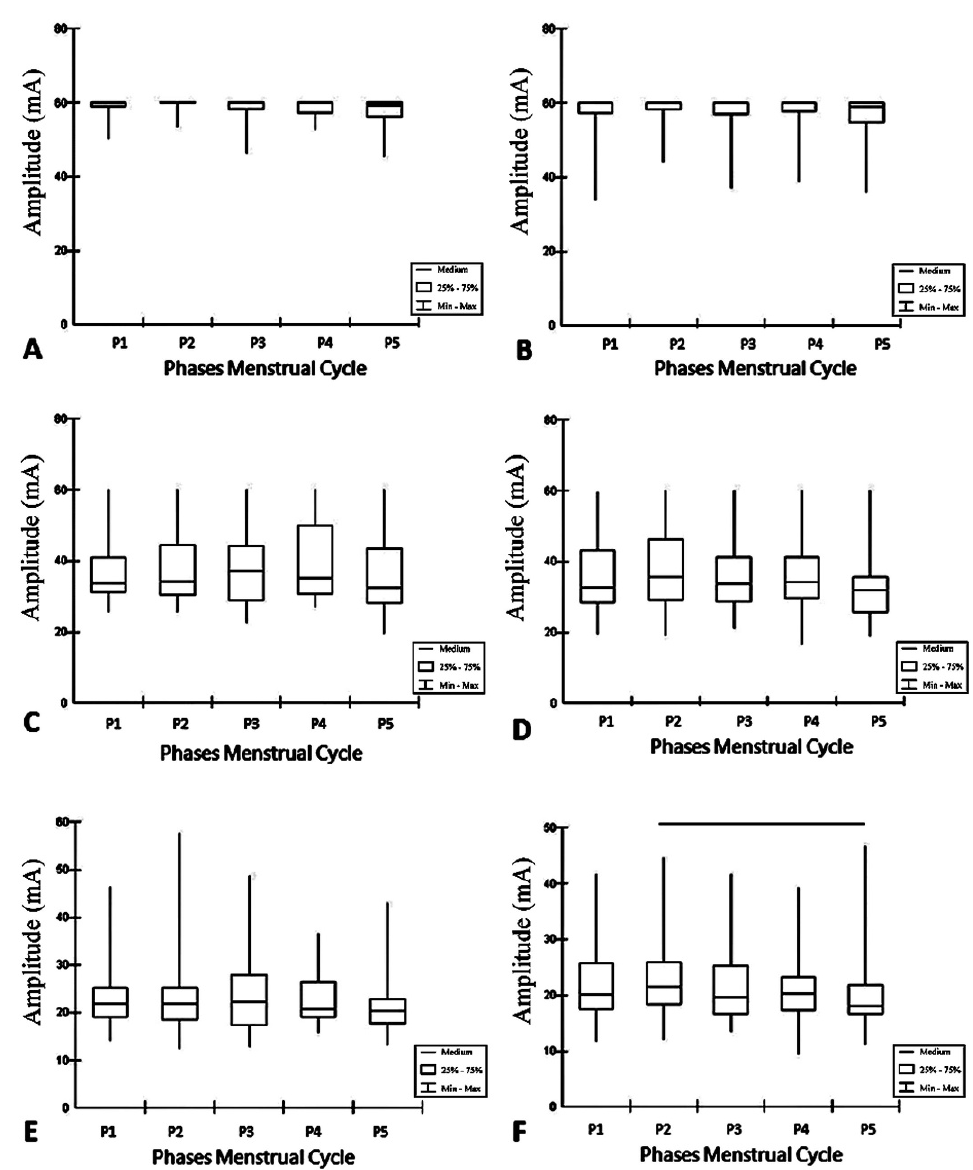
Figure 3 - The pain threshold (PT) across the following five phases of the menstrual cycle (MC): menstrual (P1), follicular (P2), ovulatory (P3), luteal (P4) and premenstrual (P5). A current of 2,500 Hz was applied in phases of 20 m s (A and B), 50 m s (C and D) and 100 m s (E and F). A, C and E represent the non-oral contraceptive group (NOCG), and B, D and F represent the oral contraceptive group (OCG). The connections indicate statistical significance ( p